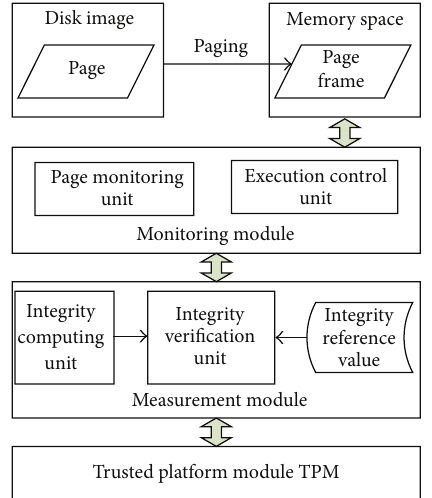
Figure 1: Dynamic integrity measurement model based on memory